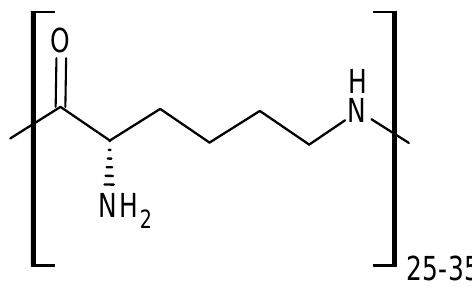
Figure 4. Structure of